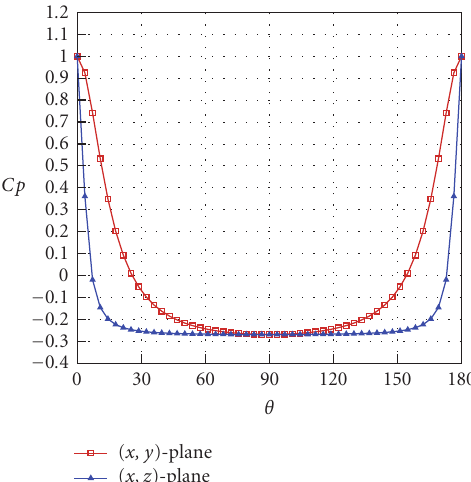
Figure 3.2. Pressure coe ffi cient distribution on the surface of an ellipsoid for two cross sections in the ( x , y )- and ( x , z )-planes with z = 0 and y = 0,